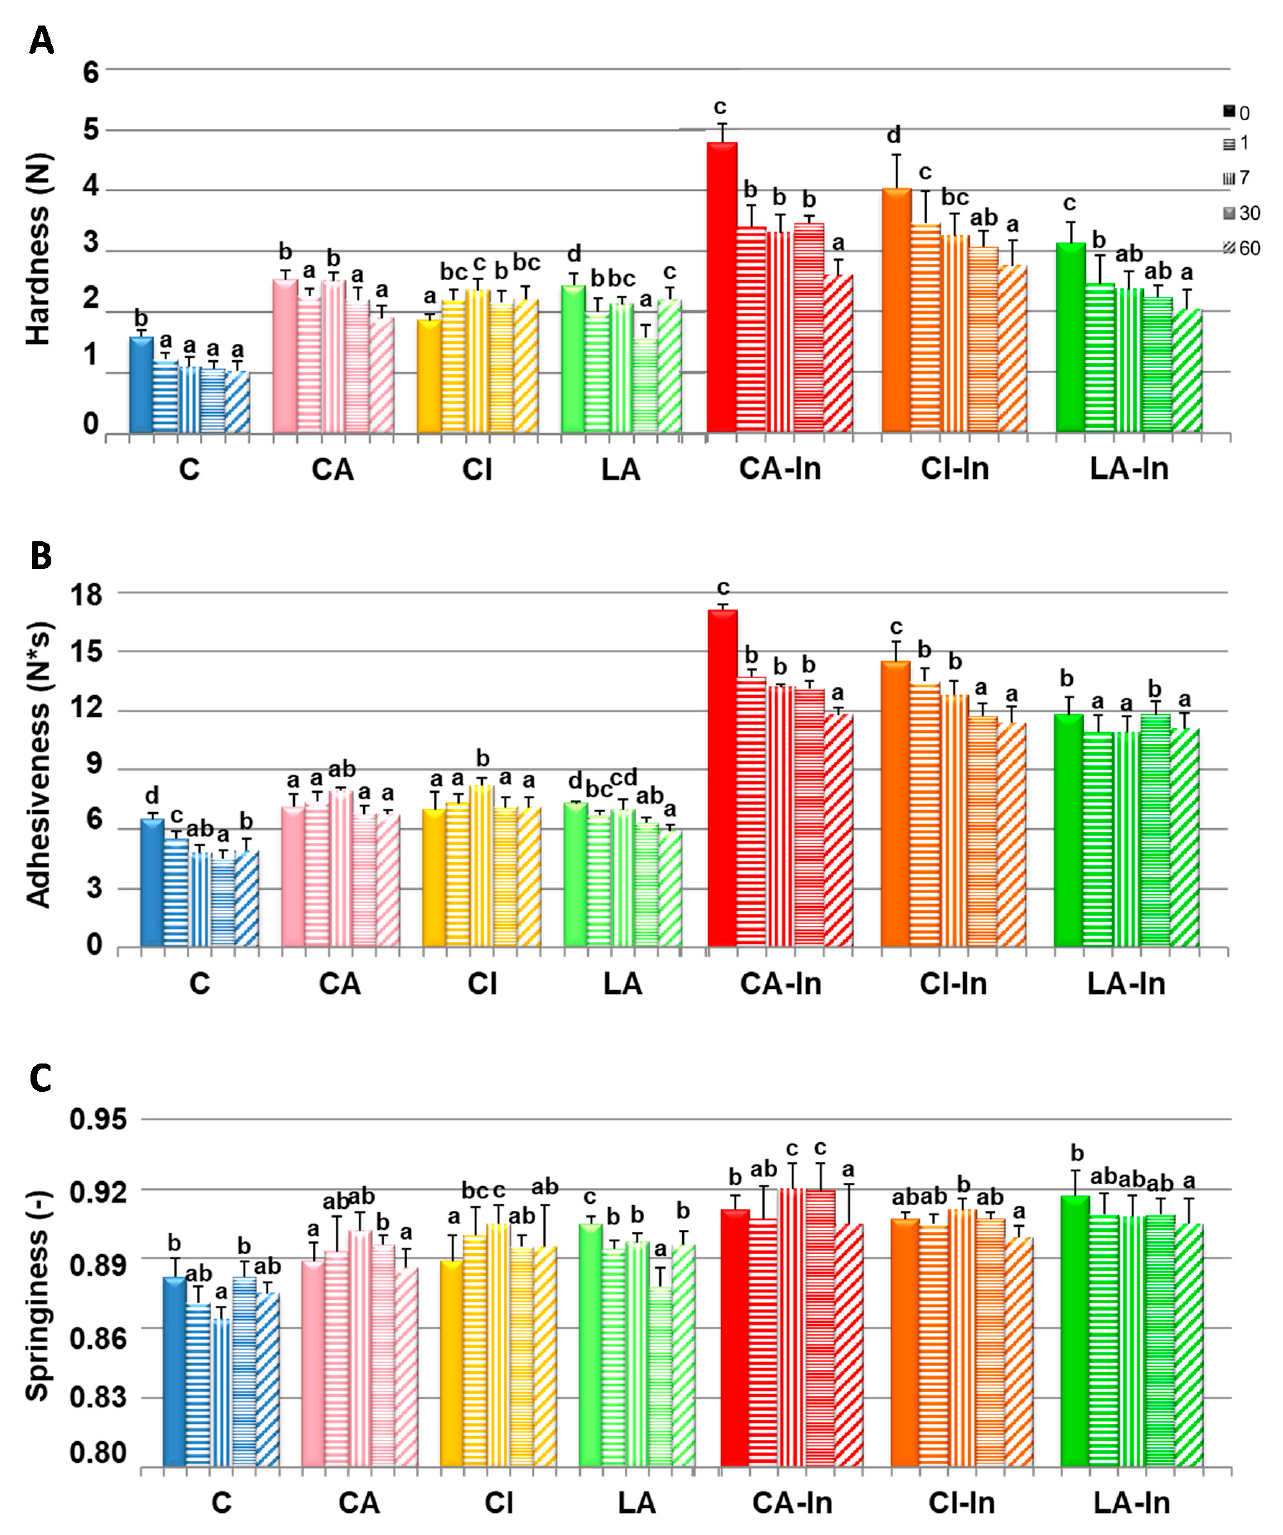
Figure 2. Textural parameters of doughs: Hardness ( A ), adhesiveness ( B ), and springiness ( C ) of the fresh and stored dough at − 18 °C for 1, 7, 30 and 60 days. Different letters in the same formulation between 0 and 60 days of storage indicate significant differences ( p < 0.05). Bars: mean ± standard deviation; (-): unitless parameter.